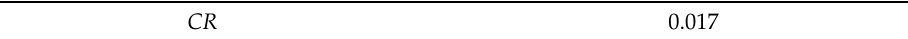
Table 4. Consistency ratio.